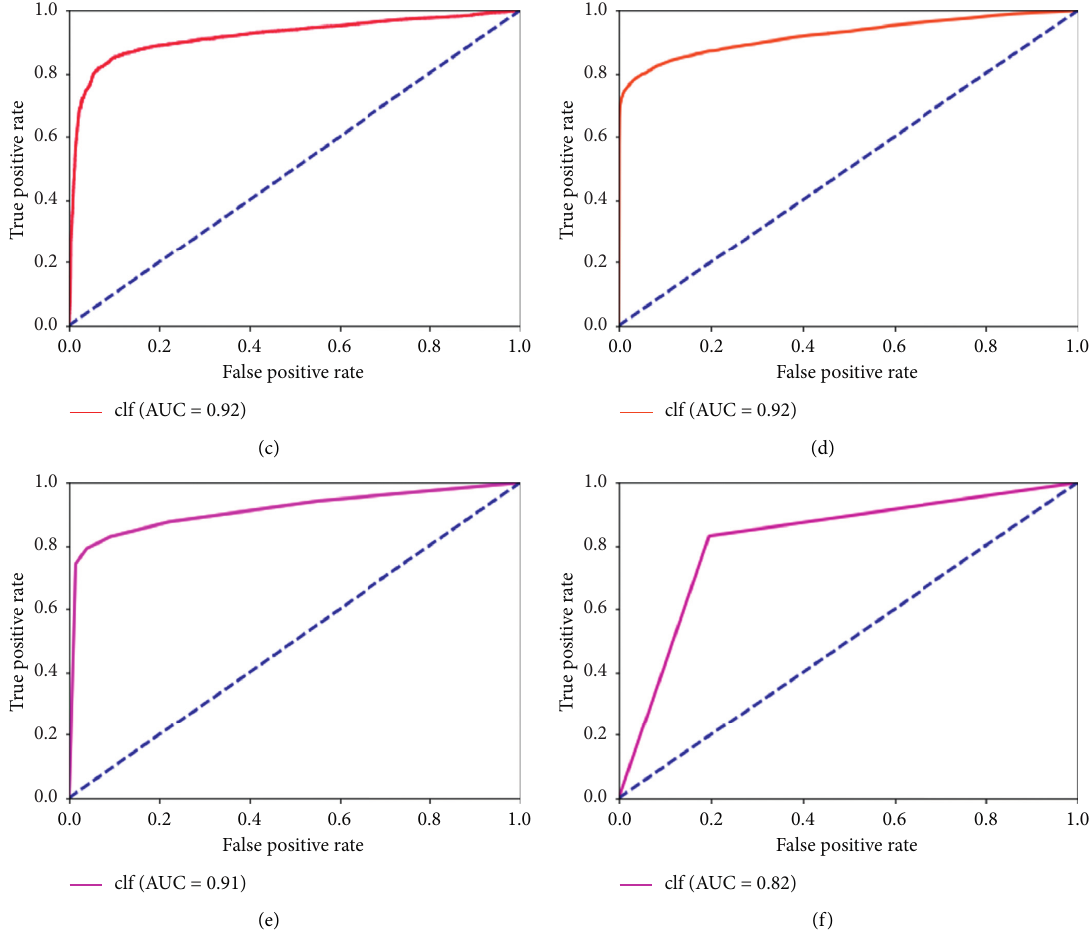
Figure 12: Comparison of six models’ ROC curves. (a) BPnn ROC. (b) SVM ROC. (c) Logistic ROC. (d) RandomForest ROC. (e) KNN ROC. (f) Tree